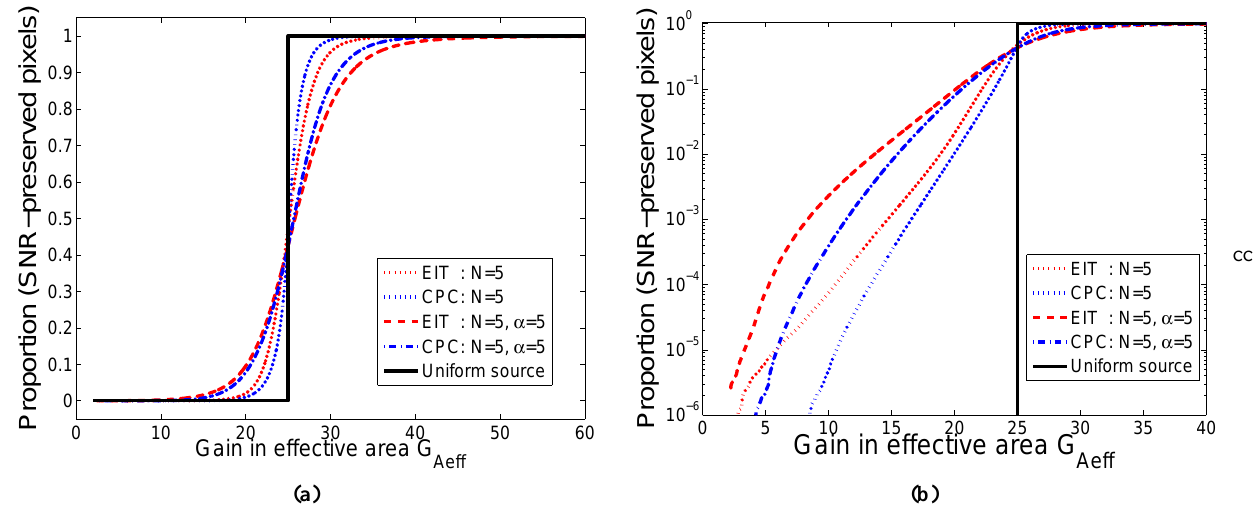
Fig. 6. Simulation of the proportion of pixels in an HRI instrument at perihelion that will conserve the same SNR as in the case of EIT at L1 (we term these “SNR-preserved pixels”) given a factor of increase of the effective area in (a) linear and (b) semi-logarithmic representation. Both EIT data (Real) and synthetic data (CPC) are represented in case of 1) a better angular resolution ( N = 5), 2) a better angular resolution and a smaller distance ( N = 5 ,α = 5). For a gain in effective area equal to 15, 1 . 6% of the pixels are SNR-preserved on real EIT data when N = 5 ,α = 5. This figure becomes 0 . 2% when G A eff = 10 only.